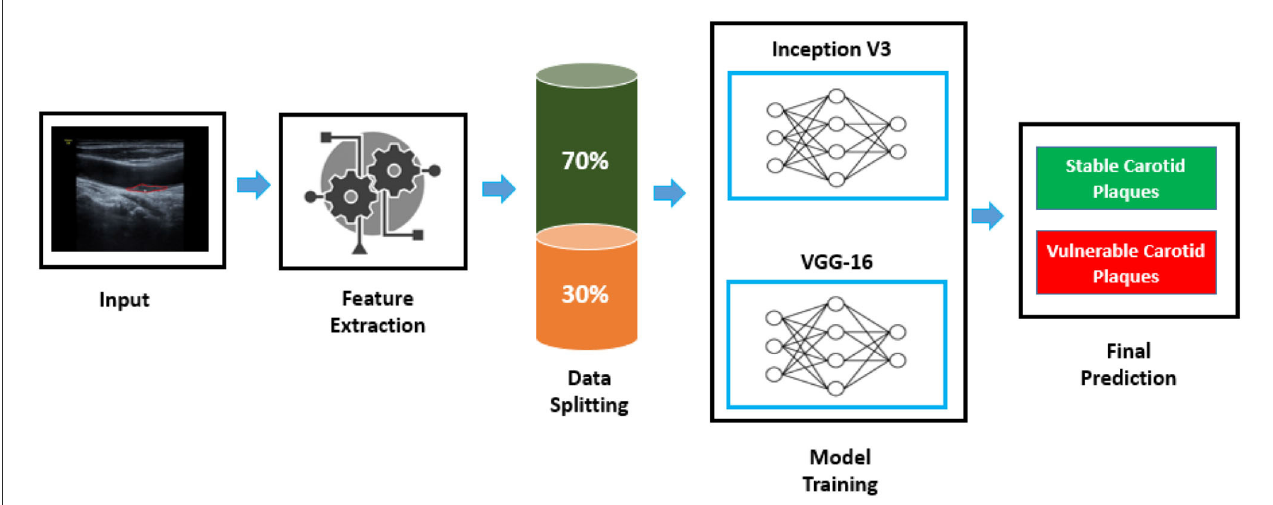
FIGURE1 Proposed framework to classify color Doppler ultrasound images. An image is fed to the feature extraction module of a neural network; then, data are split to the train and test set. Inception V3 and VGG-16 are trained according to the dataset to classify images into two classes.